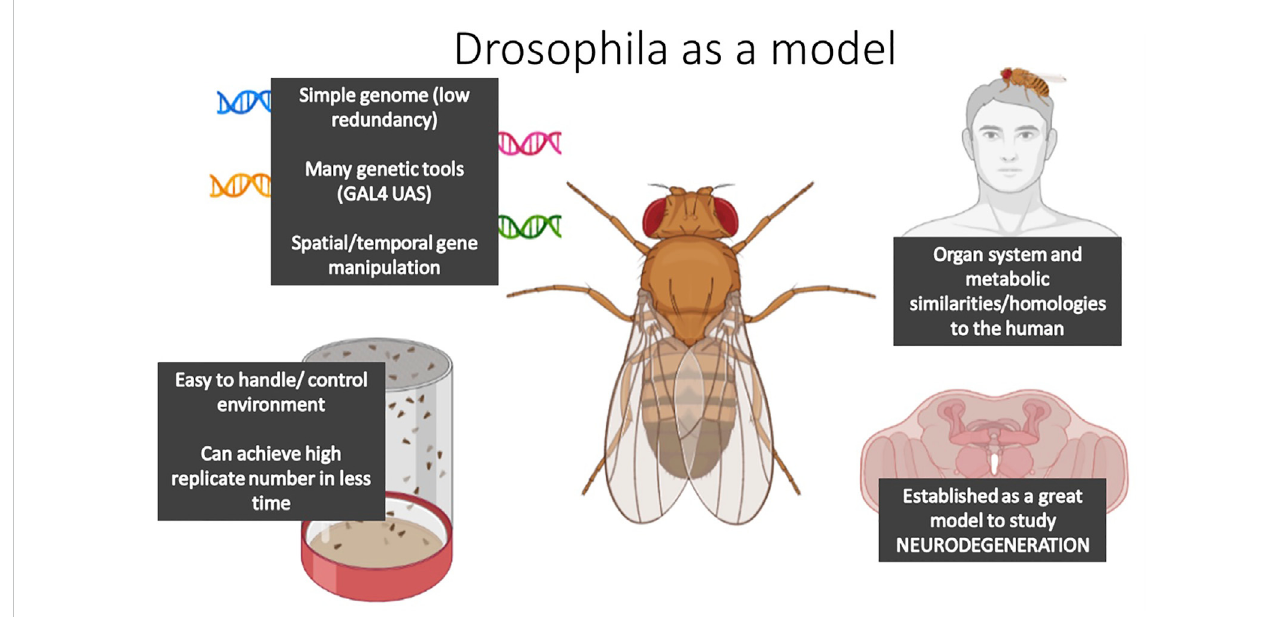
FIGURE 4 The diagram summarizes the main features that make Drosophila melanogaster a suitable model organism to study DMGB